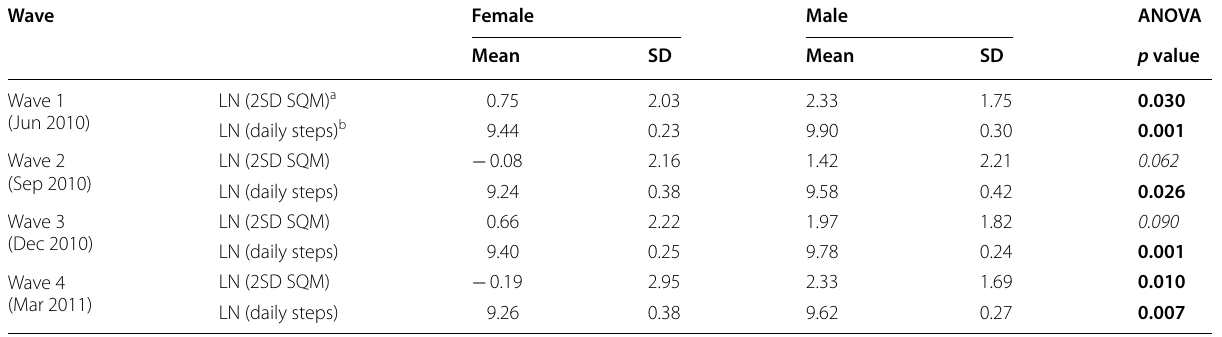
P value < 0.1 are shown italic